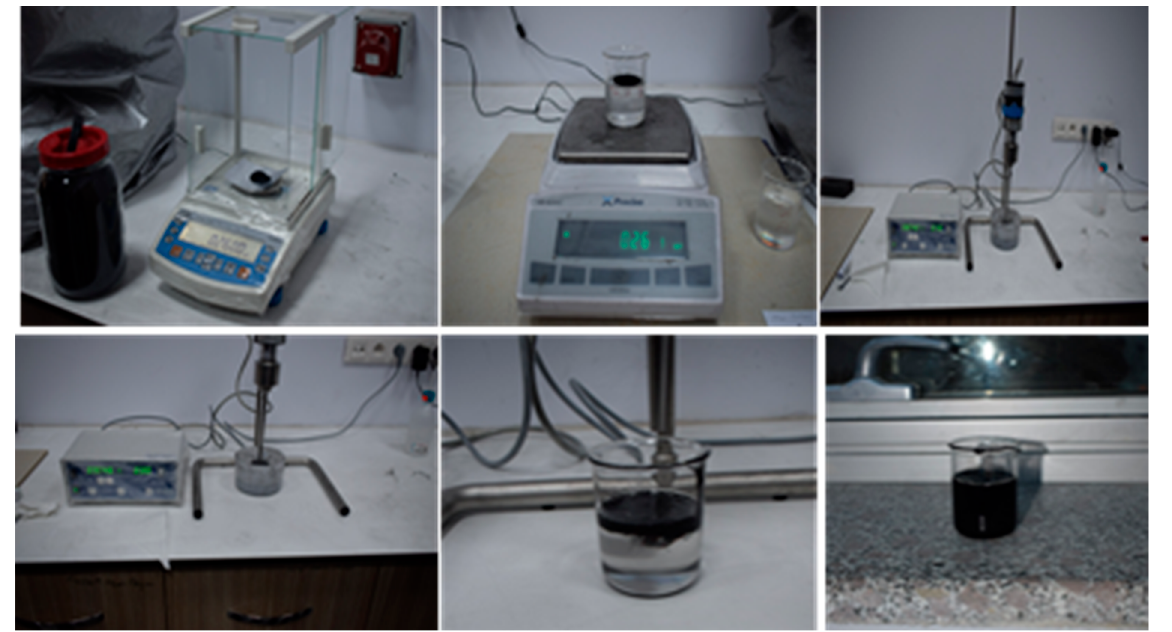
Figure 1. CNTs in epoxy resin and using the mixture of resin/CNT as a matrix of the composite.